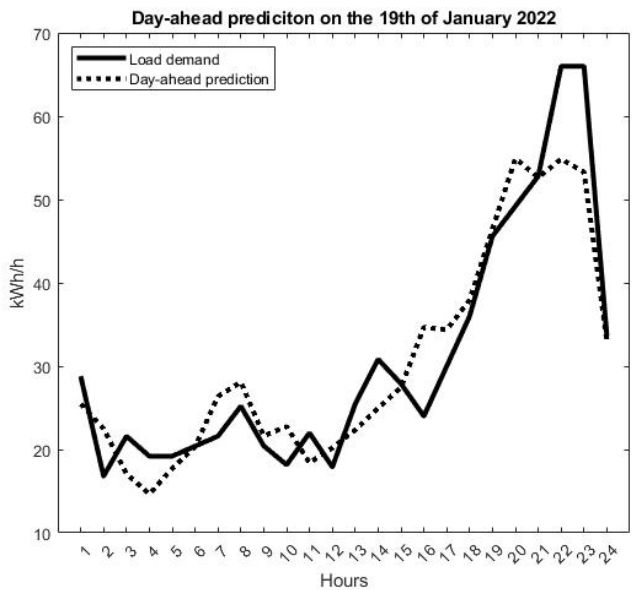
Figure 5. The mobility house’s load demand profile and the day-ahead predicted load demand profile on the 19th of January 2022, which was the day with the lowest RMSE in the testing data set.